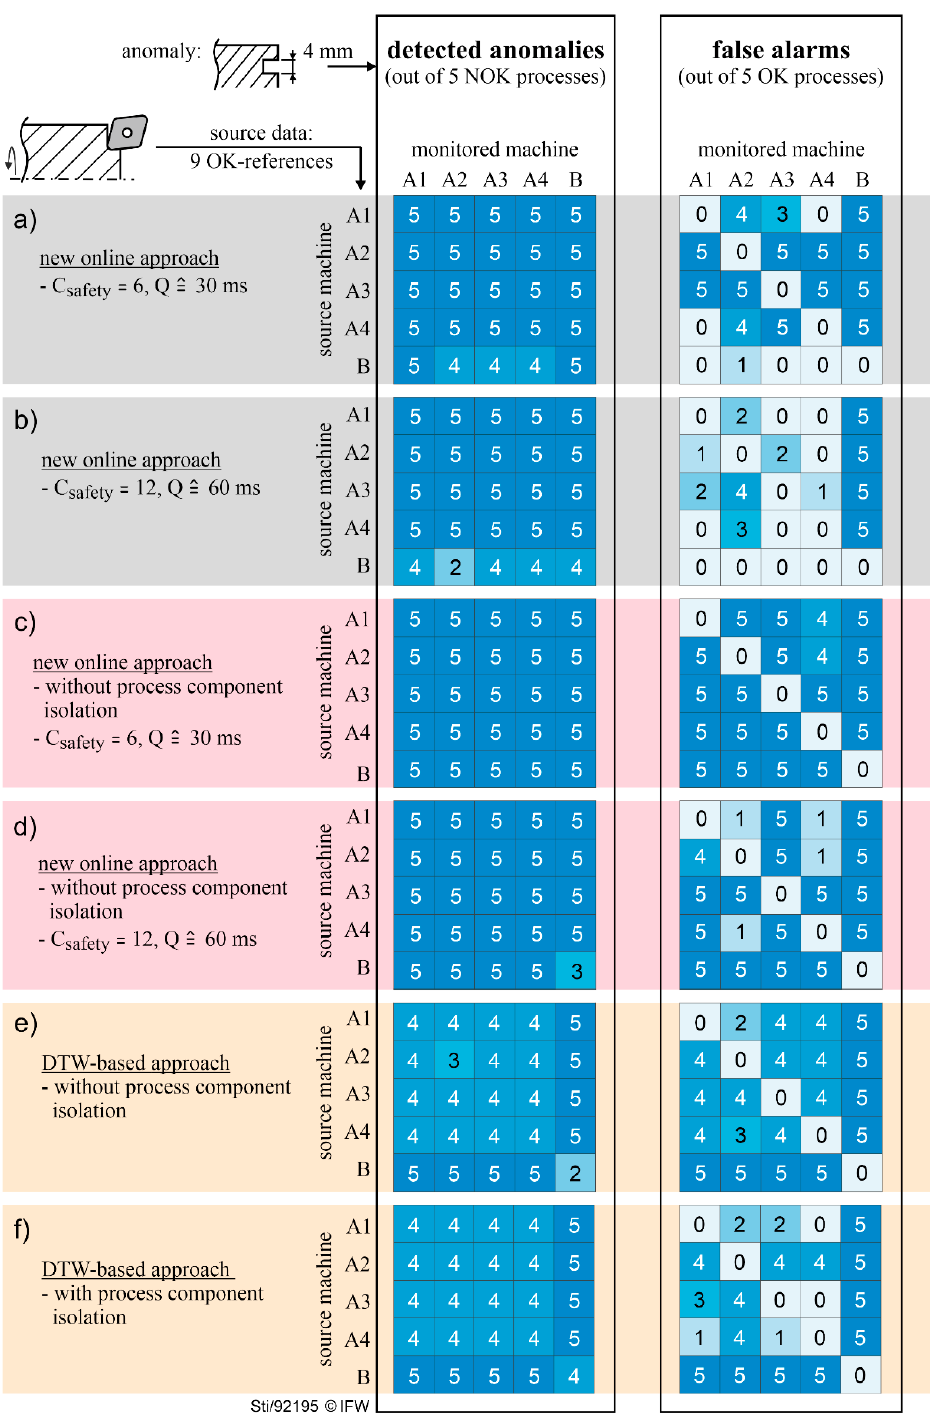
Figure 6. Detected anomalies and occurred false alarms summarized for all cutting conditions. Results depicted for individual pairs of source-target machines. ( a – d ): the proposed online method under varying input data and parameters. ( e , f ): the offline approach as a reference.